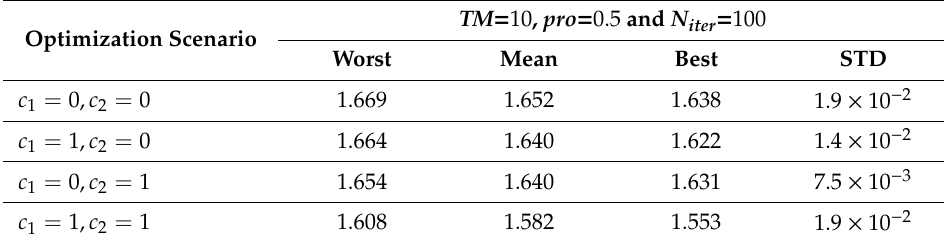
Table 8. Comparison under di ff erent values of c 1 and c 2 : IAE criterion.